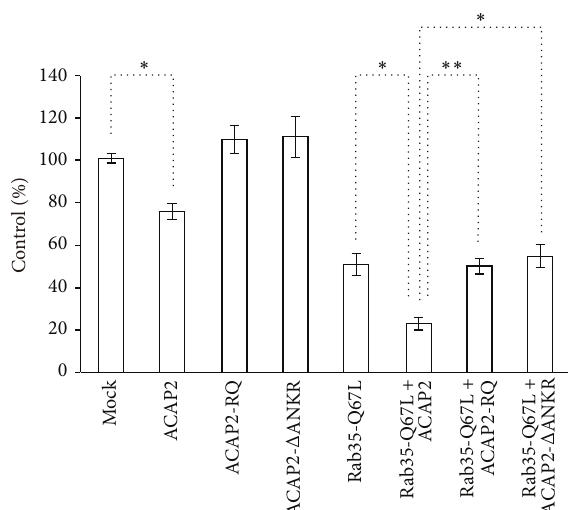
Figure 5: Effects of ACAP2 and/or Rab35 expression on phagocytosis of zymosan. RAW264 macrophages expressing GFP-ACAP2 constructs and/orTagRFP-Rab35-Q67Lwereincubatedwithzymosanat37 ∘ Cfor30minutesandwerefixed.Theefficiencyofphagocytosiswascalculated based on 50 transfected and 50 untransfected cells. The results were expressed as a percentage of control (untransfected) cells. Data shown are the mean ± SEM of ten independent experiments. Mock indicates cells transfected with GFP and TagRFP. One-way ANOVA followed by Tukey’s test was used for statistical analysis ( ∗ 𝑝 < 0.05 , ∗∗ 𝑝 < 0.01 ).